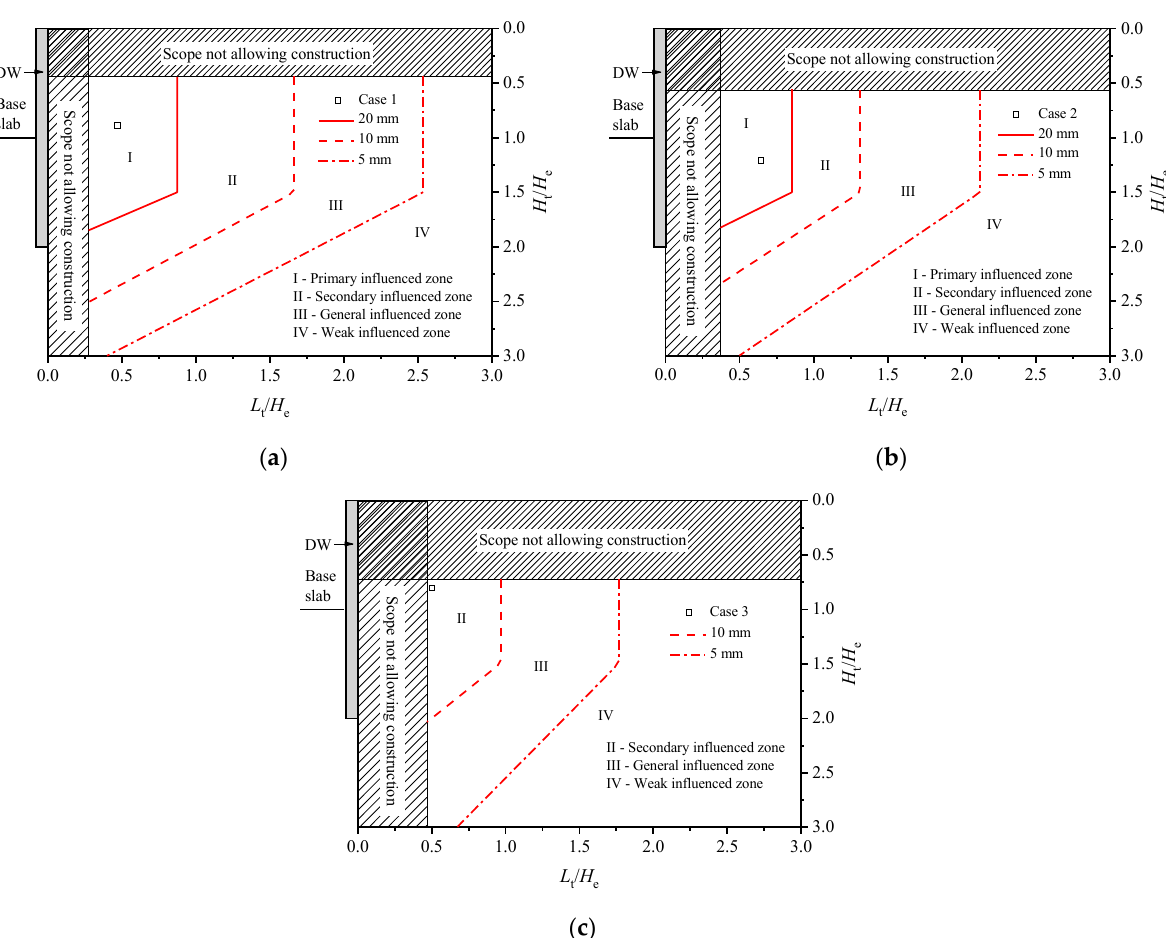
Figure 14. Comparison of predicted influenced zone with the results in case histories: ( a ) Comparing with Case 1; ( b ) Comparing with Case 2; ( c ) Comparing with Case 3.